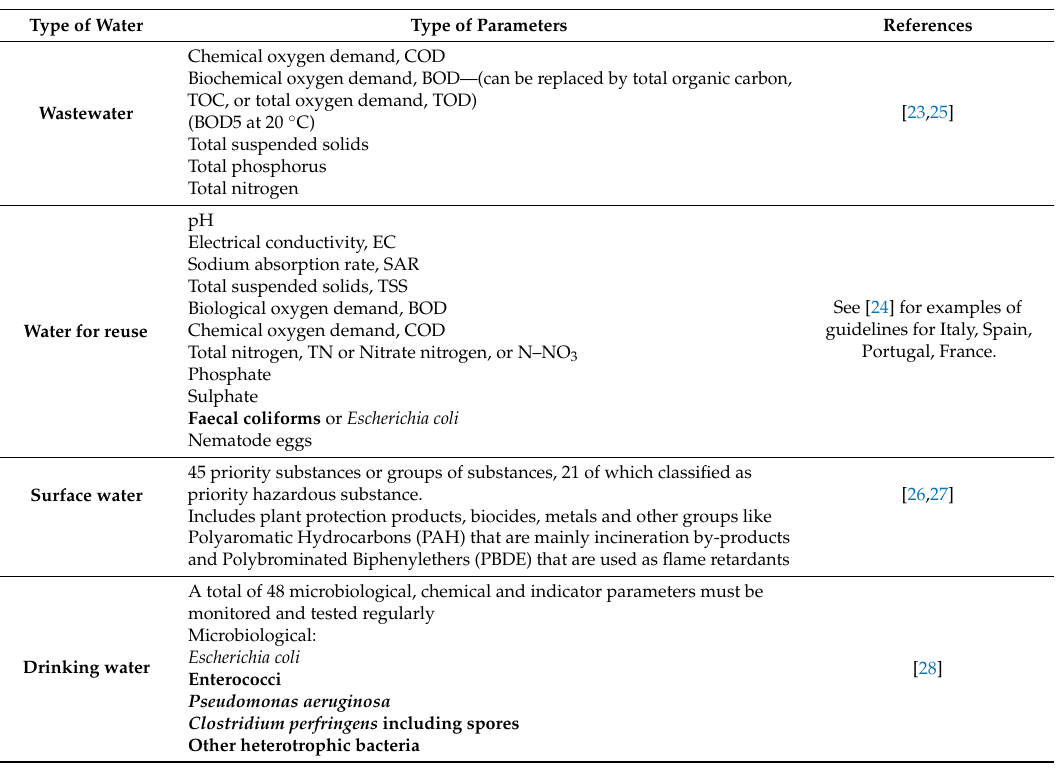
Table 1. Type of parameters and treatment objectives in different sectors of the urban water cycle according to European